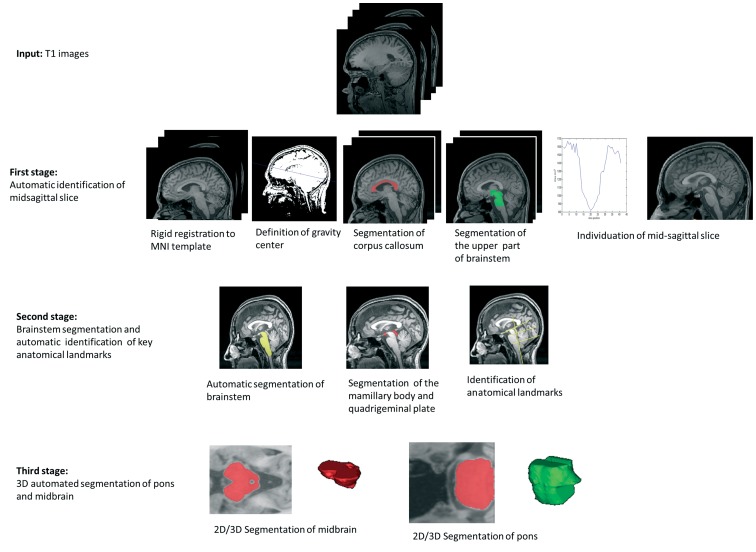
Stages of algorithm.